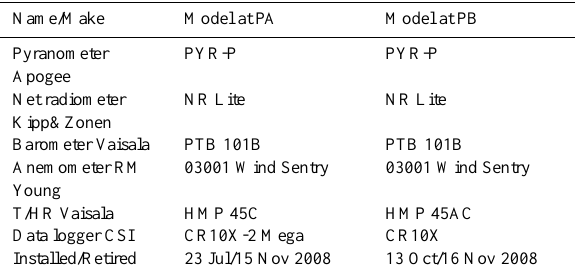
Table 1. Sensors and equipment for PA and PB Campbell Scientific Inc. automatic weather stations, including functioning